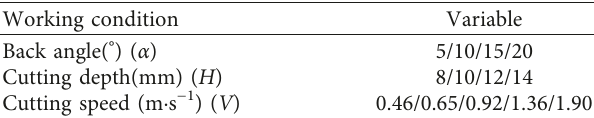
Table 2: Cutting